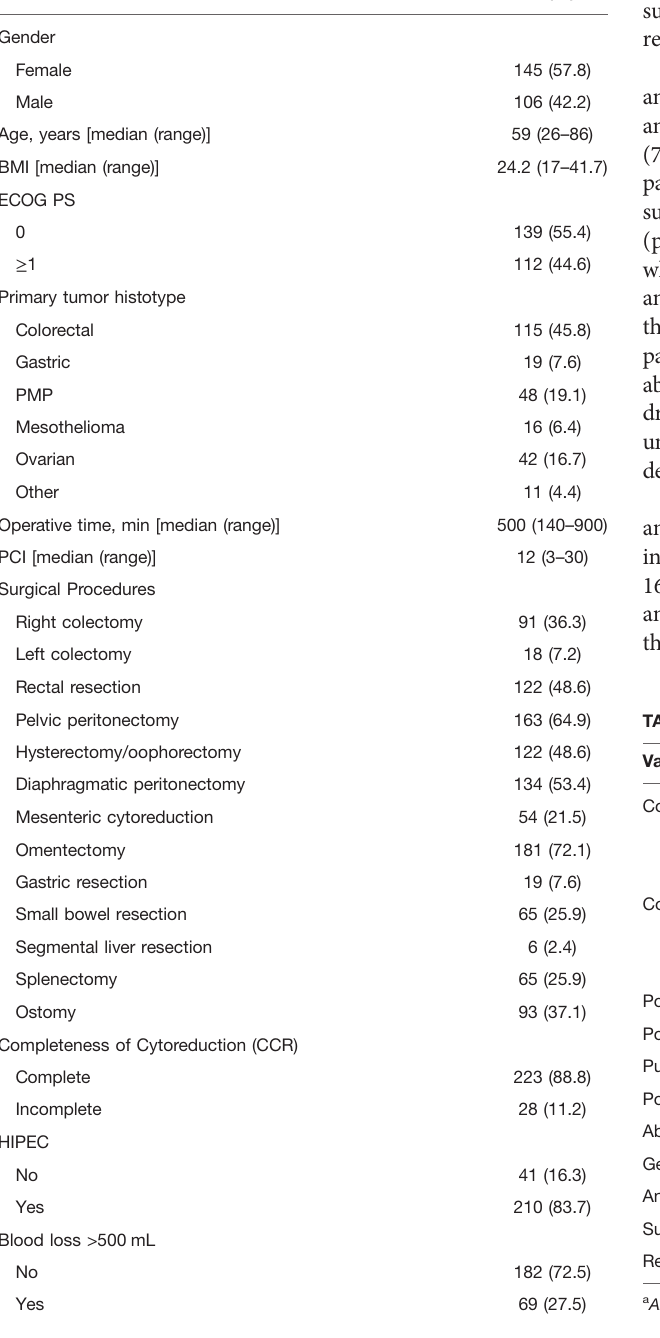
TABLE 1 | Baseline characteristics and operative